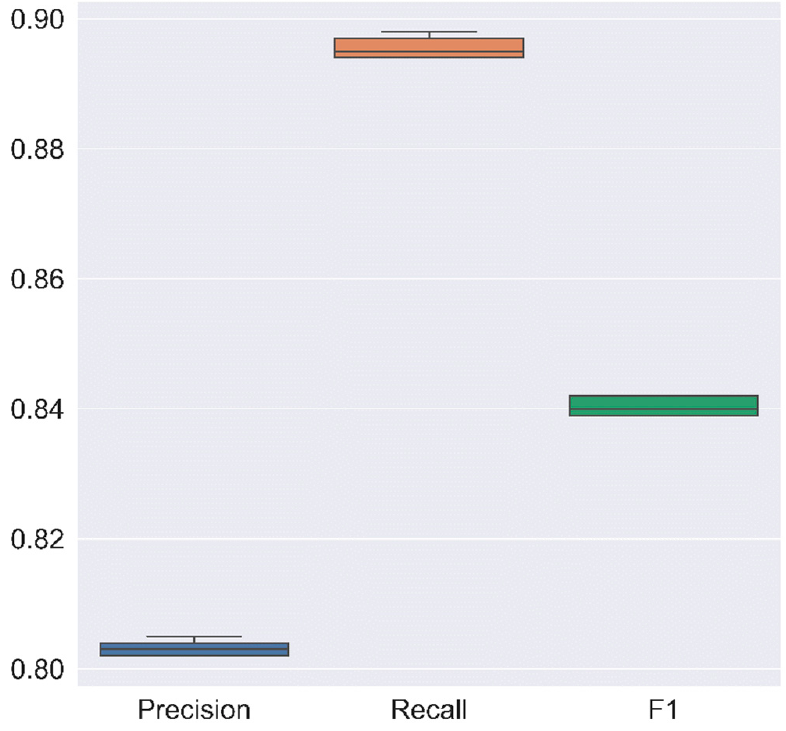
Figure A2. Dispersion of efficiency indicators of the cross validations for each bioclimatic model using the raining data (80% of the present biome